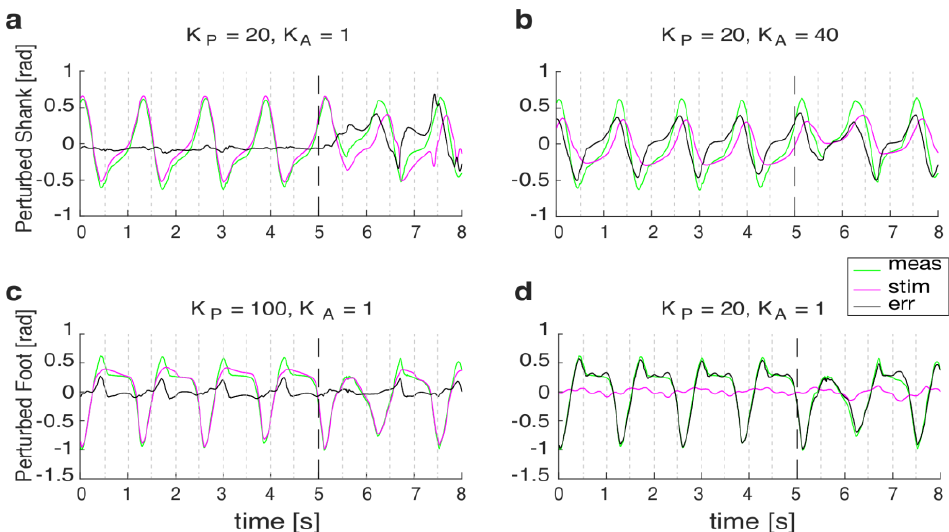
Figure 4. Representative examples of the AOs’ tuning, showing measured signals by the IMUs (green lines), the estimated signals by the AOs (magenta lines) and their differences (i.e., error; black lines). Accurate and inaccurate tunings of the AOs are reported for the perturbed shank and foot (( a ), ( b ), ( c ) and ( d ), respectively) before and after the onset of the perturbation (i.e., the dashed lines at 5 s).